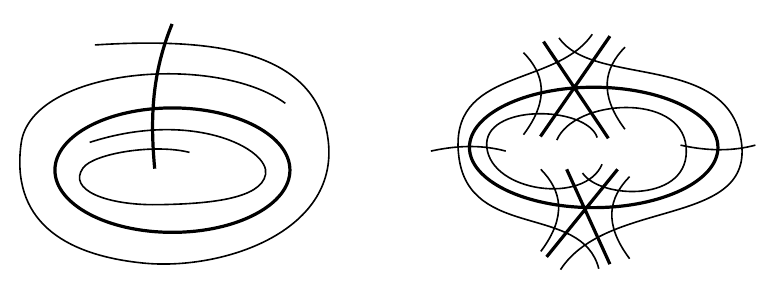
Fig. 4 – Curvature lines near a spherical umbilic